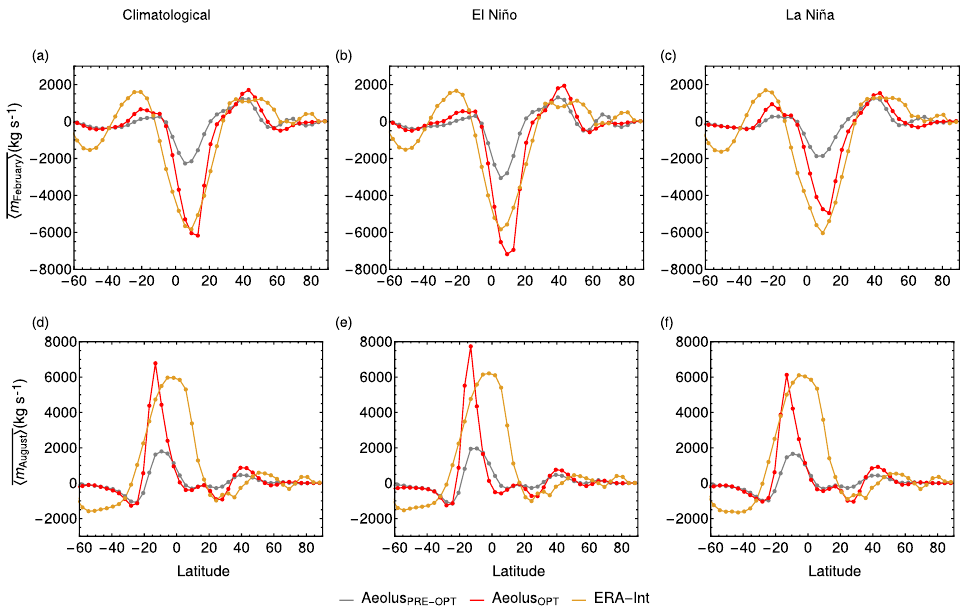
Figure 6. Zonal-mean large-scale mass flux (cid:104) m (cid:105) . Panel (a) shows the climatological monthly mean zonal-mean mass flux in February, (b) the monthly mean zonal-mean mass flux of El Niño February months and (c) the monthly mean zonal-mean mass flux of La Niña February months. Panel (d) displays the monthly mean climatological zonal-mean mass flux in August, (e) the monthly mean zonal-mean mass flux in El Niño August months and (f) the monthly mean zonal-mean mass flux in La Niña August months. The yellow line represents zonal-mean large-scale mass flux obtained by reanalysis data, the gray line is the zonal-mean large-scale mass flux from Aeolus using pre-optimized parameters and the red line represents the zonal-mean large-scale mass flux from Aeolus using optimized parameters.